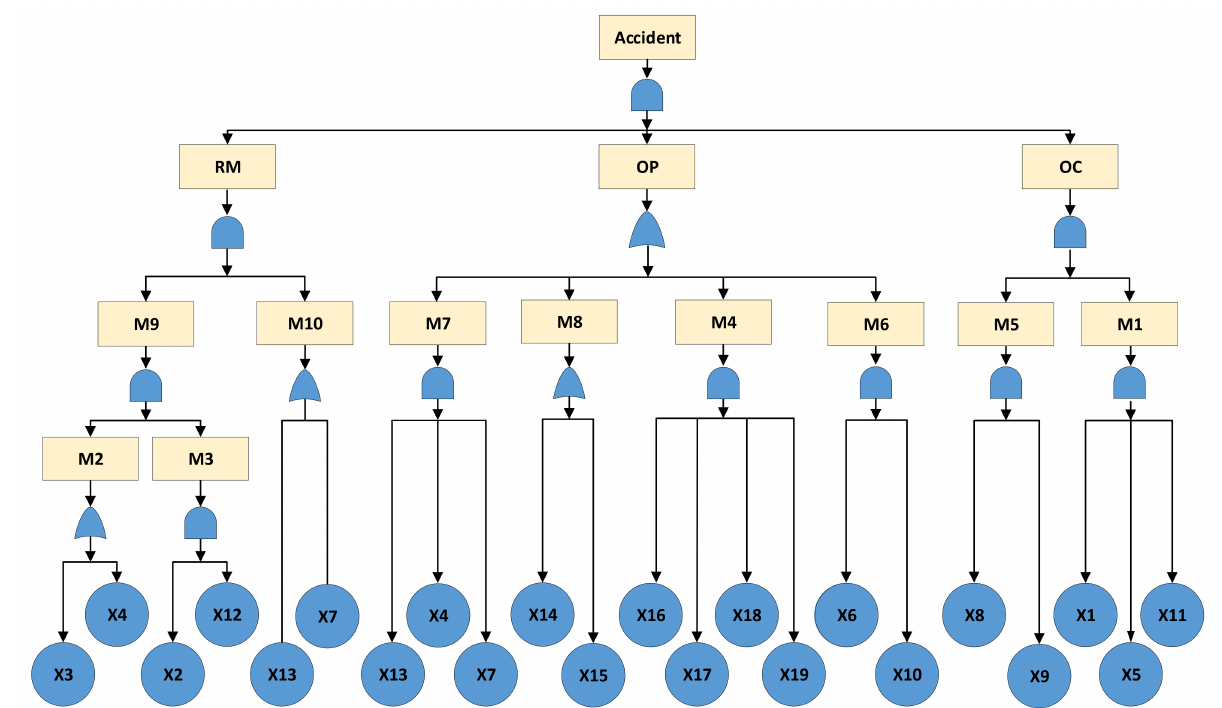
Figure 7. Cause-effect diagram of the fault tree for the suffocation